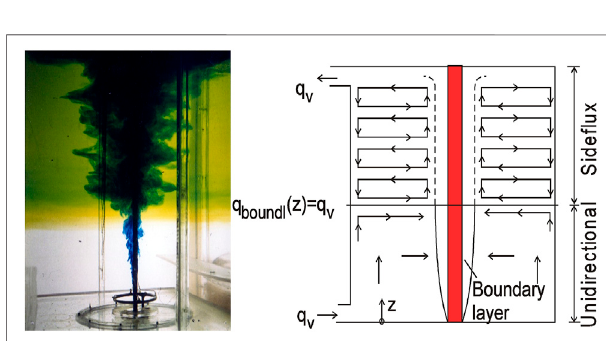
FIGURE 7 | Visualization of a fl ow generated by a buoyancy source that spans the whole height based on paragraph 8.9.6 in the study by Etheridge and Sandberg (1996).